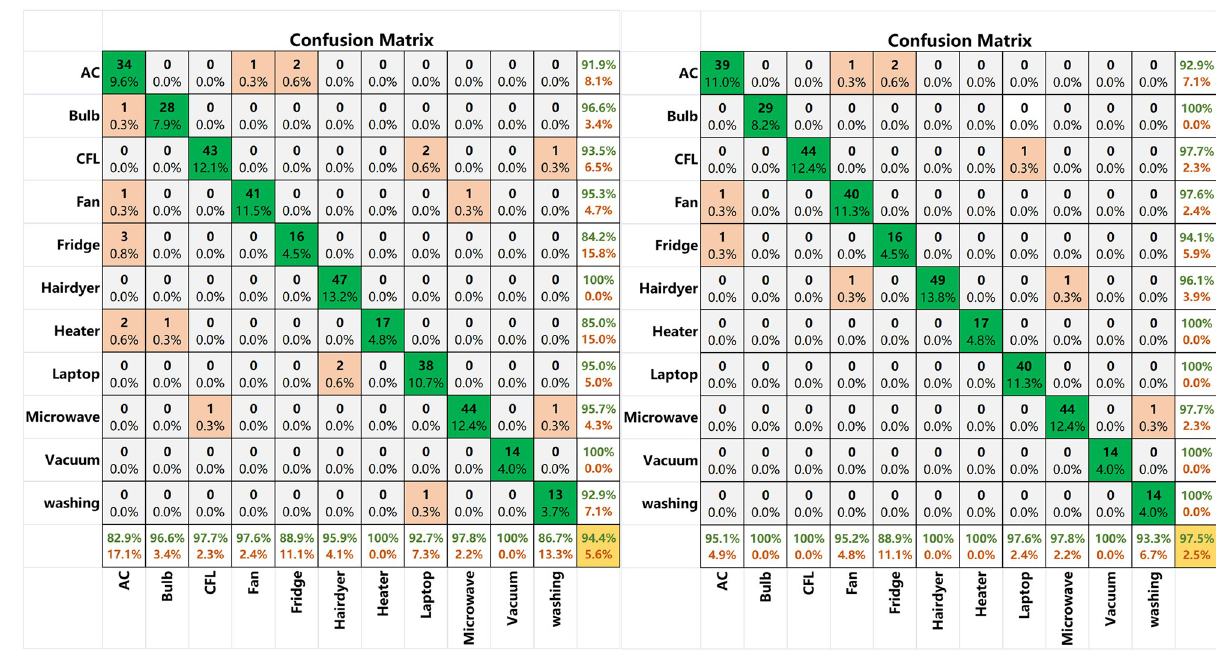
Fig 12. The confusion matrix for appliance loads of the PLAID dataset. (a) Confusion matrix based on color V-I trajectory image before model transfer. (b) Confusion matrix based on color V-I trajectory image after model transfer.